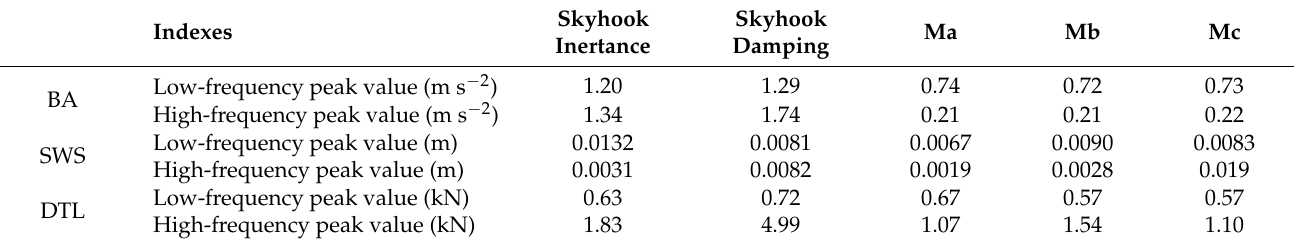
Table 10. Comparison of peak RMS values for single-skyhook and multi-hook control